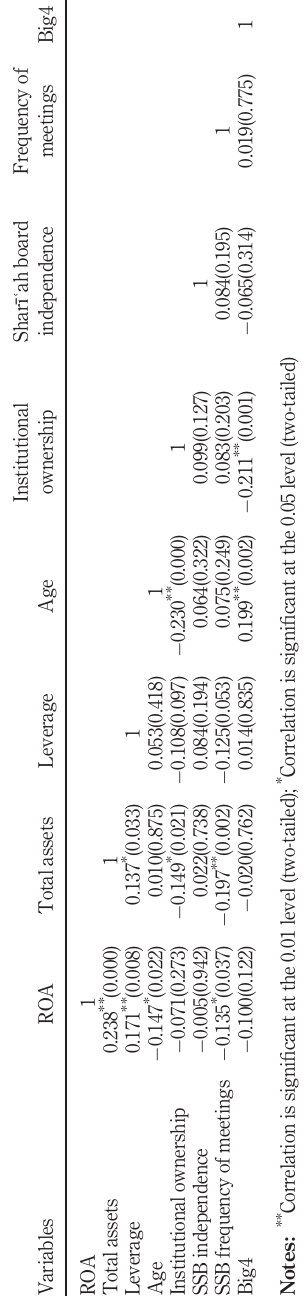
Table V. Correlations